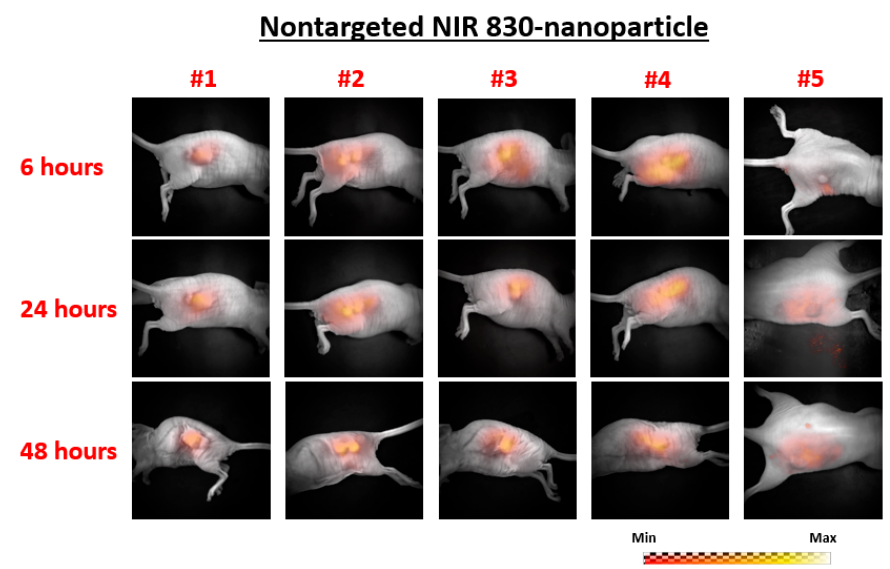
Figure 1. Planar fluorescence images of the five mice in the nontargeted nanoparticle–near-infrared 830 (nontargeted NIR 830) group at 6, 24, and 48 h post injection of nanoprobes.